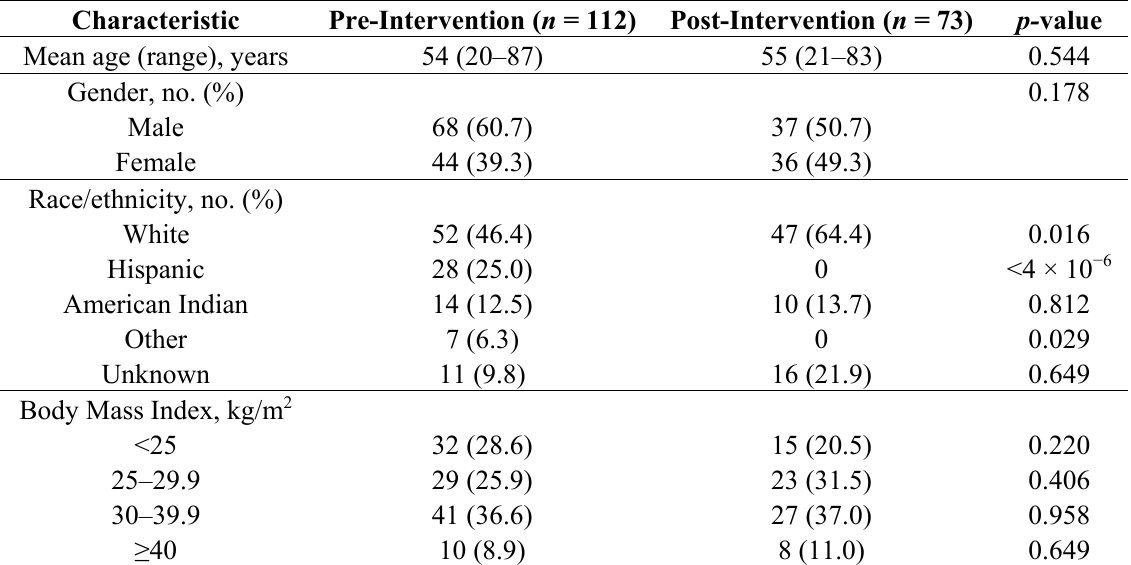
Table 2. Patient Demographics.